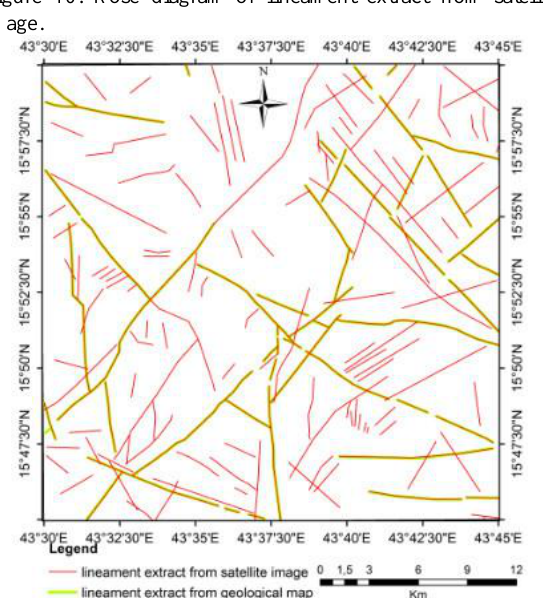
Figure 11. Superposition the lineament extraction from satellite image with geological map of the study